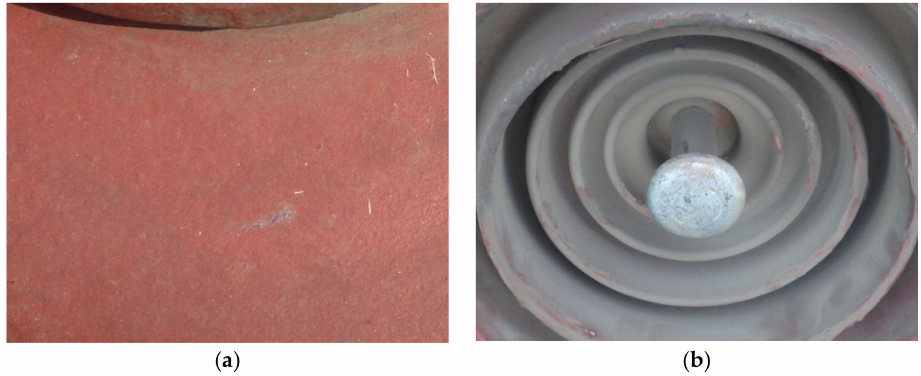
Figure 8. The contaminated insulator. ( a ) The upper surface; ( b ) The lower